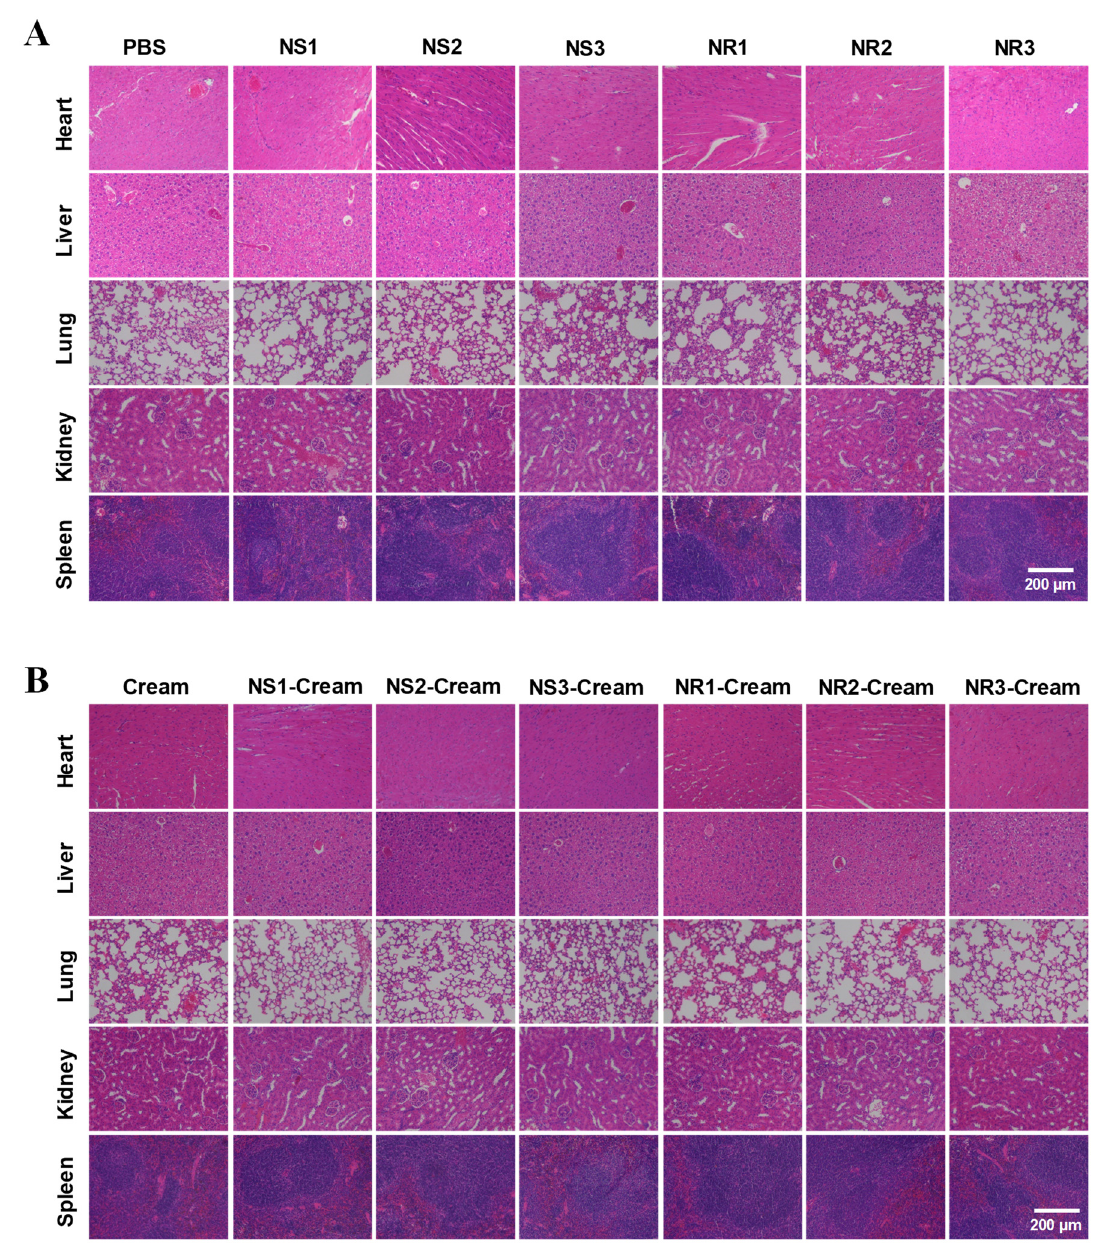
Figure 7. H and E staining of major organs (heart, liver, lung, kidney, spleen) of hairless mice after dermal exposure to Au NMs or Au NM − Cream for 30 days. ( A ) Au NMs; ( B ) Au NM − Cream.